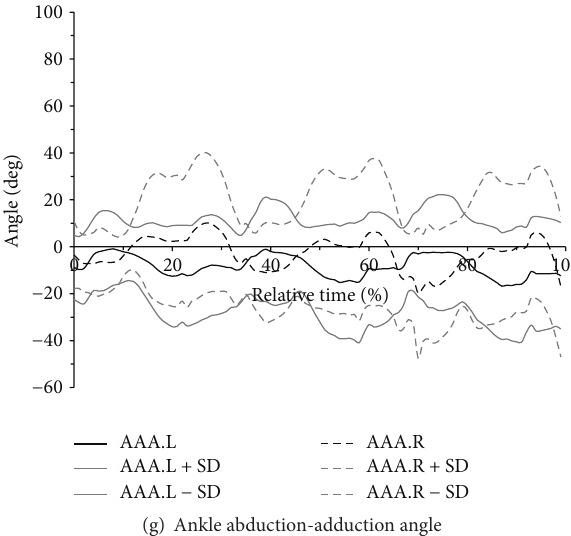
Figure 2: Instantaneous changes in the angle in the area of lower limb joints with respect to specific axes during a 30-meter sprint acceleration phase along a straight line for the left limb (continuous line) and right limb (dashed line).